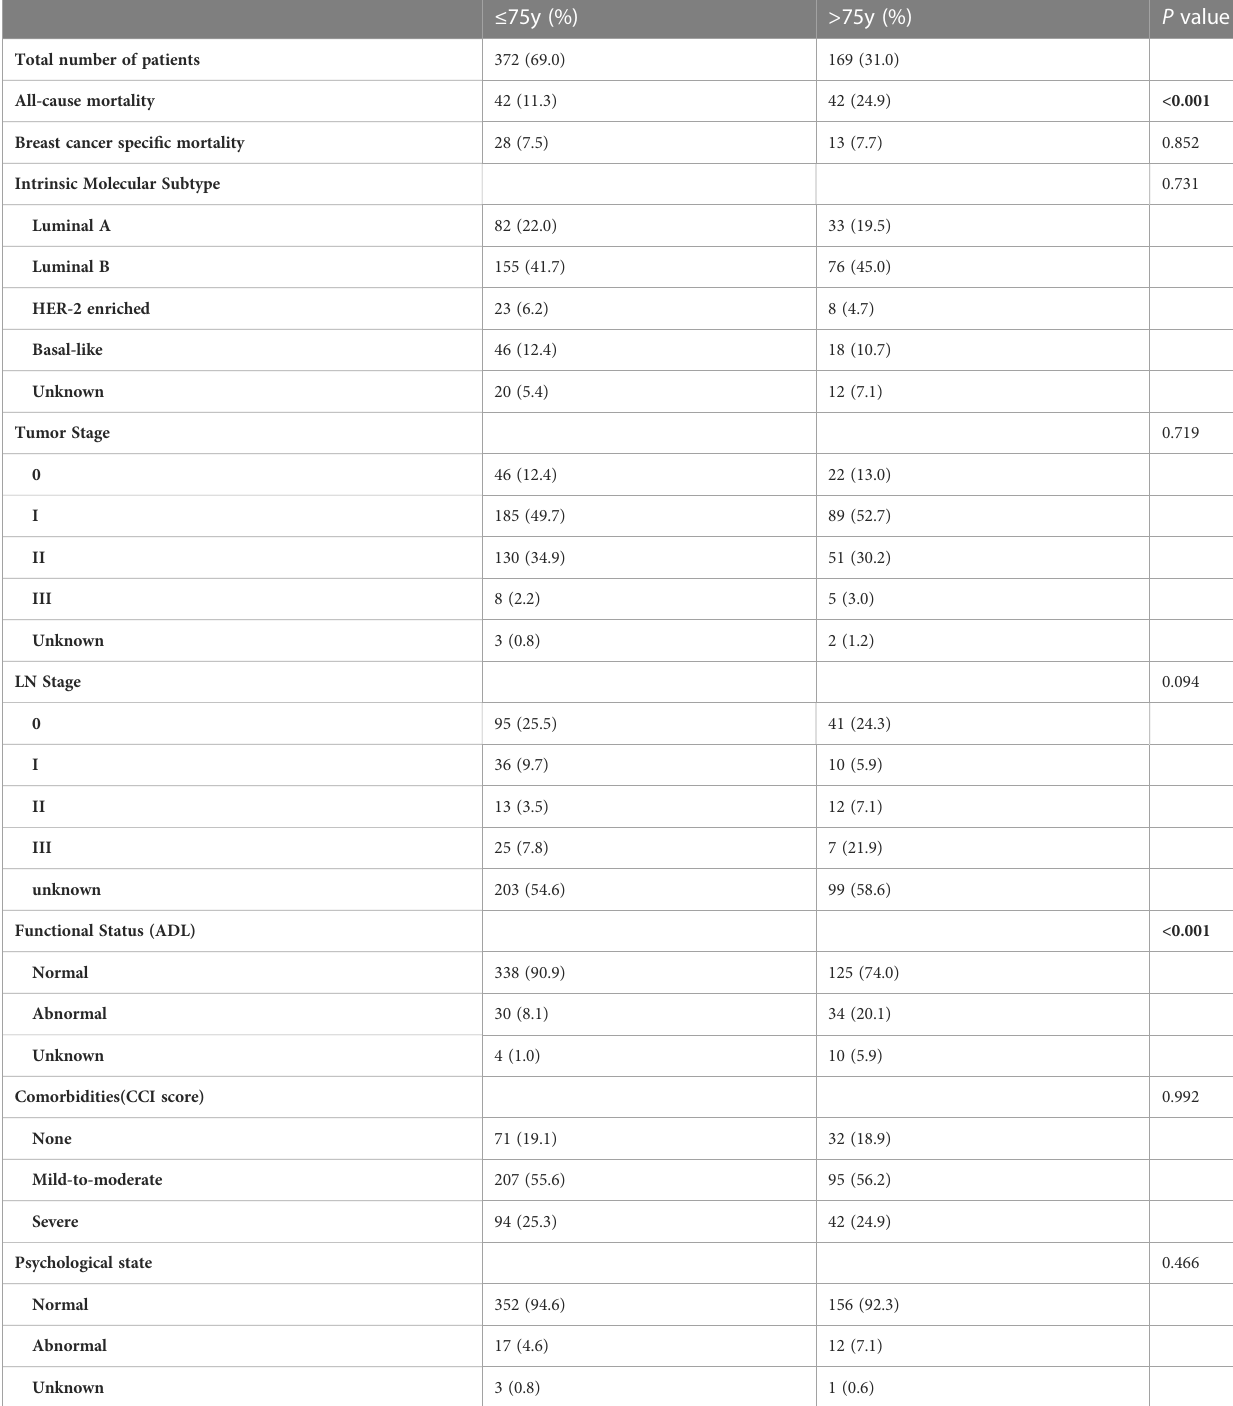
TABLE 1 Patient and tumour characteristics in groups strati fi ed by